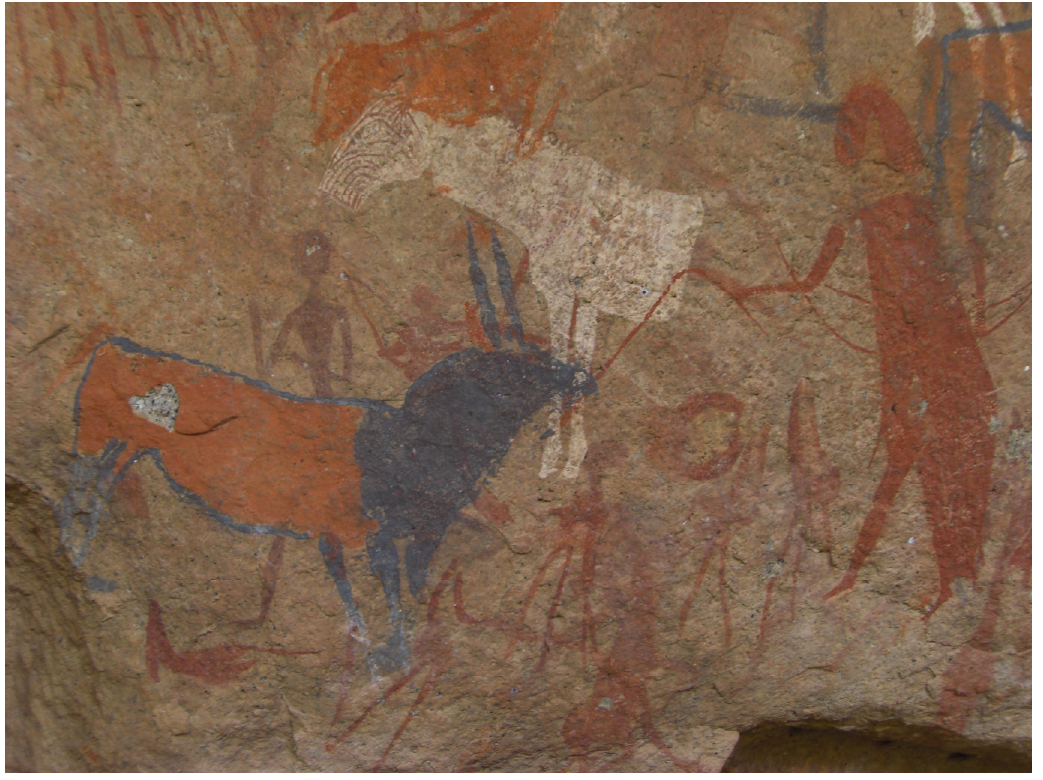
Figure 4. Human figure drawing forward an eland, Upper Brandberg/Dâures. Source: Sian Sullivan, 2008, personal